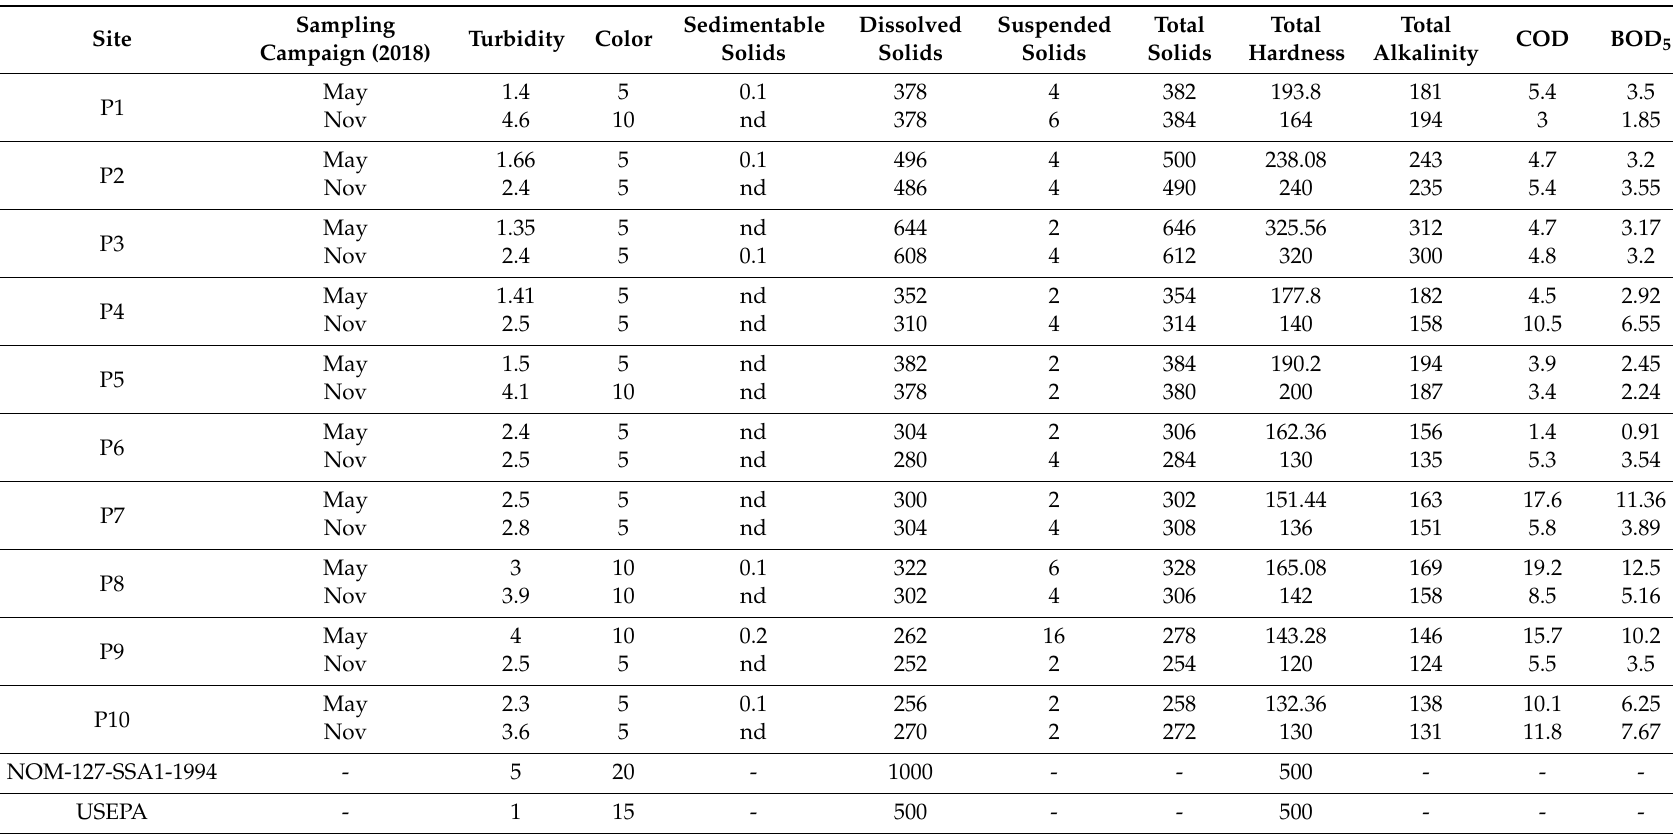
Table 7. Physicochemical parameters in the water samples from the 10 sites: turbidity (NTU), color (Pt / Co), and sedimentable, dissolved, suspended and total solids, total hardness, total alkalinity, chemical oxygen demand (COD) and biochemical oxygen demand (BOD 5 ). Concentrations of solids, hardness, and alkalinity are expressed in mg / L. Concentrations of COD and BOD 5 are expressed in mg O 2 /